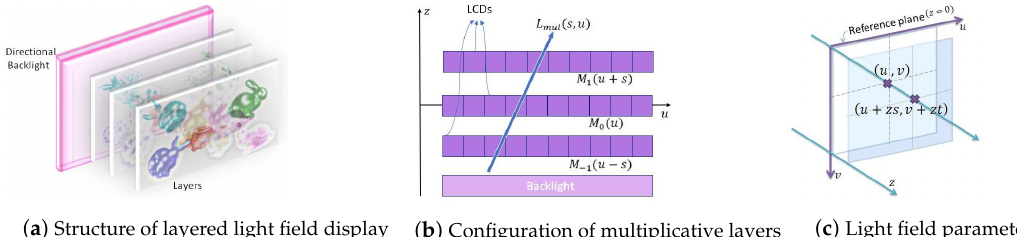
Figure 1. Light field is defined in 4-D space. The structure ( a ) and configuration ( b ) of layered light field display for constructing multiplicative layers are shown in 2-D for simplicity; ( c ) the light ray is parameterized by point of intersection with the ( u , v ) plane and the ( s , t ) plane located at a depth z